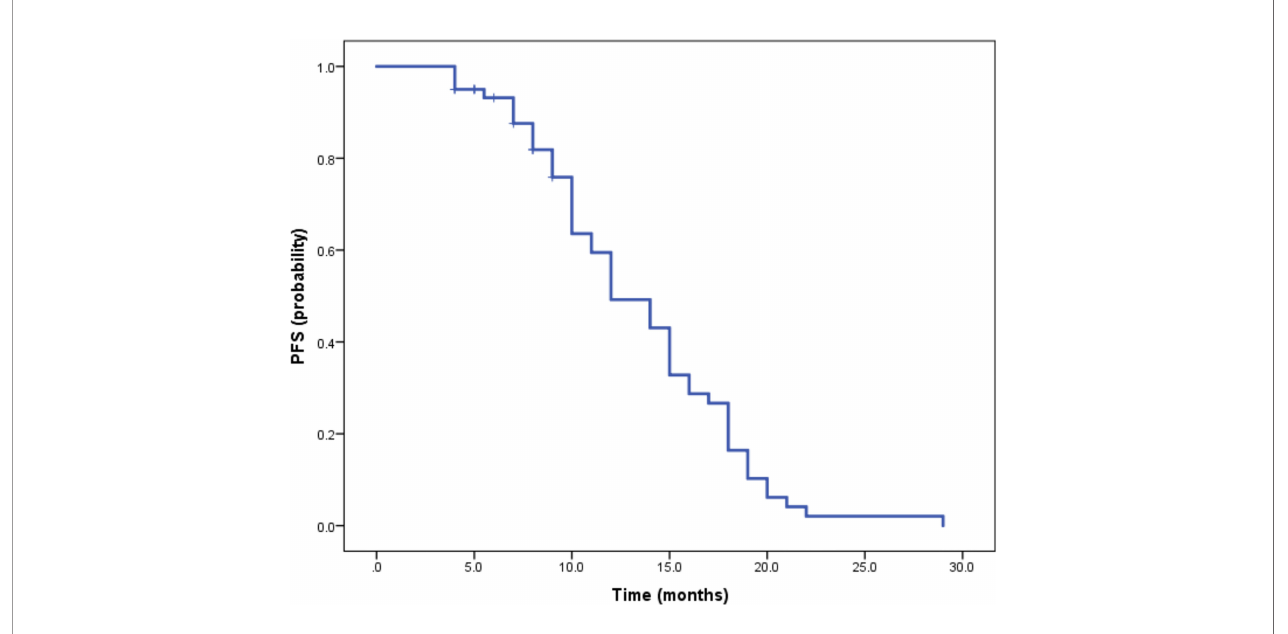
FIGURE 3 | Kaplan-Meier method-based estimate of PFS by